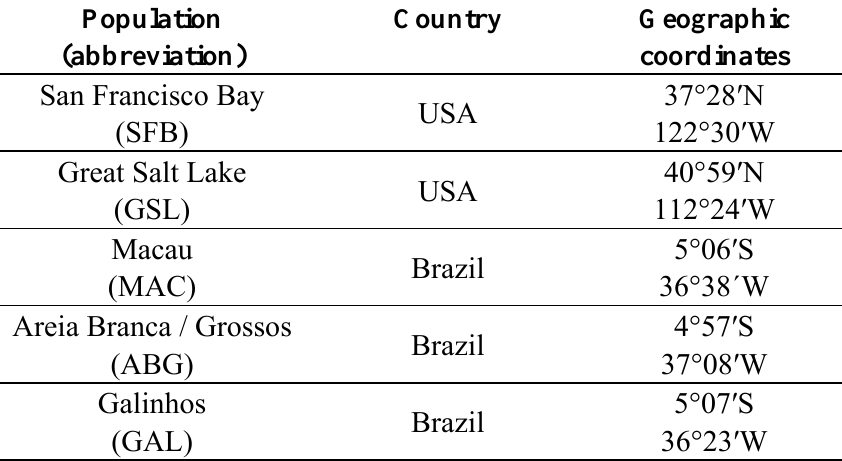
Table 2. List of Artemia franciscana populations